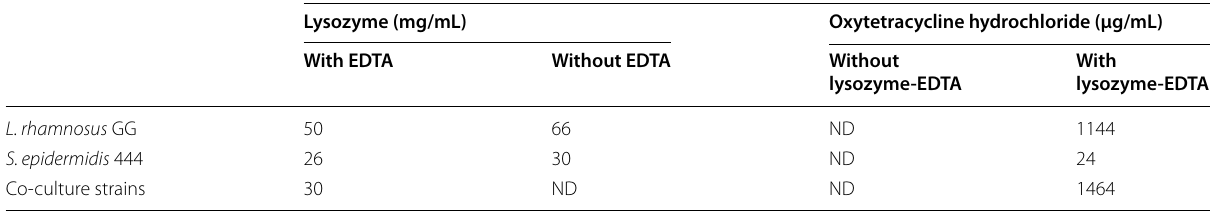
ND indicates that MIC, IC 50 and MCBEC 50 was not